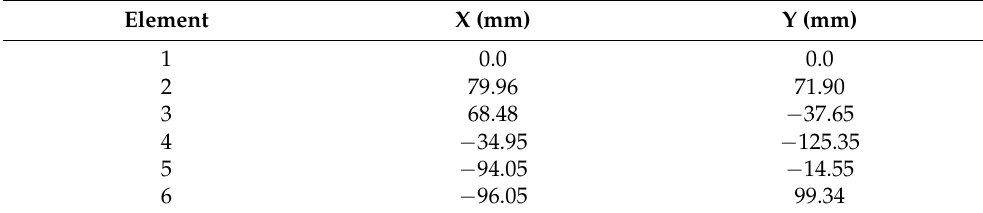
Figure 2. ( a ) 6-element 2–18 GHz CBSA array, array hardware ( b ) without and ( c ) with absorbing material. Table 1. Antenna element random locations in the randomly-spaced CBSA array.